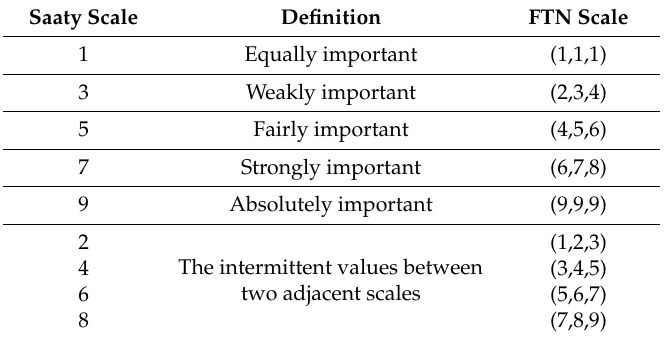
Table 1. Linguistic terms and the corresponding